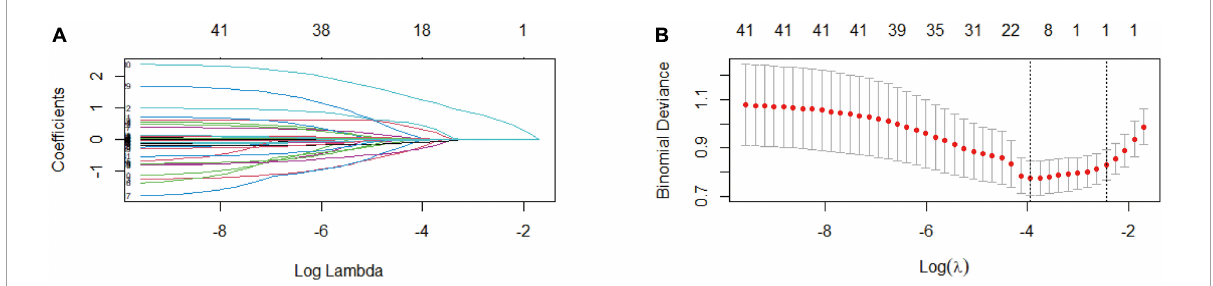
FIGURE2 Exclude all missing values feature selection (Per-Protocol set) using the least absolute shrinkage and selection operator (LASSO) binary logistic regression model ( n = 310). (A) LASSO coefficient profiles of the 41 baseline features, where the minimum lambda resulted in the single candidates of serum cystatin C (S-CysC) with non-zero coefficients. (B) Dotted vertical lines in the LASSO regression showed the optimal diagnostic model (left vertical line) and the most parsimonious model (right vertical line). The LASSO regression identifies S-CysC as the single predictor from the most parsimonious model.